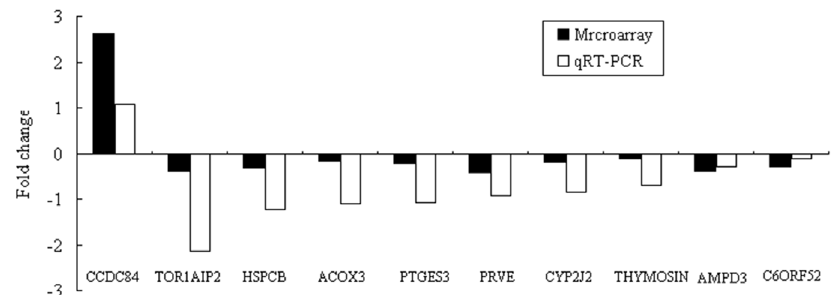
Figure 3. Validation of the 10 differentially expressed genes obtained from microarray analysis by qRT-PCR, n=3. The p -values of the qRT-PCR data are as follows: 0.0067 (C6ORF52), 0.3920 (CCDC84), 0.3661 (THYMOSIN), 0.8195 (PRVE), 0.3154 (HSPCB), 0.6534 (CYP2J2), 0.002 (AMPD3),